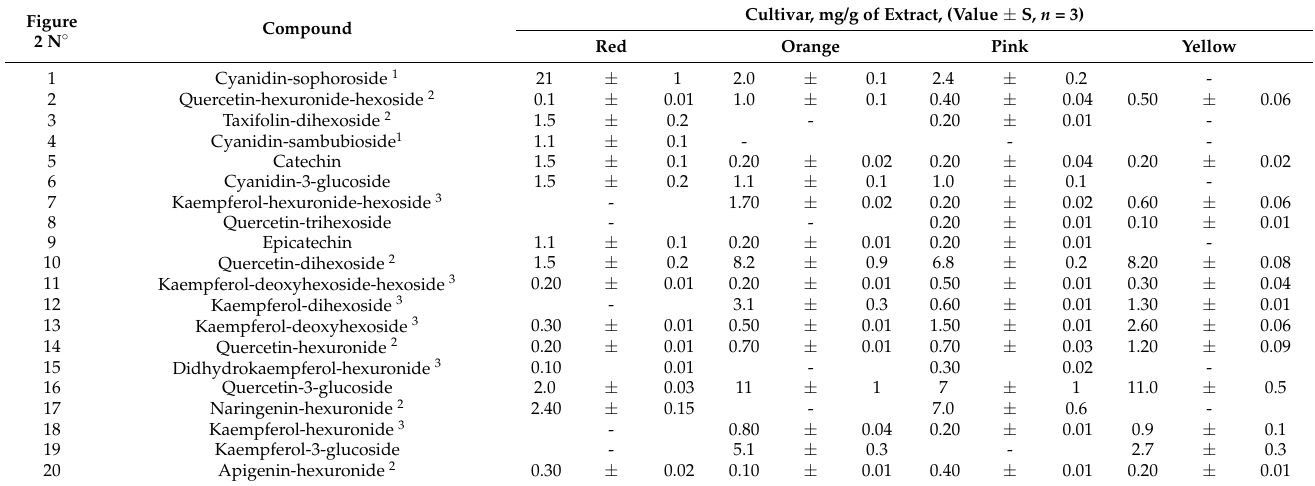
Table 3. Phenolic compound content (mg/g) in the hydroalcoholic H. rosa-sinensis flower extracts of cultivars studied in this